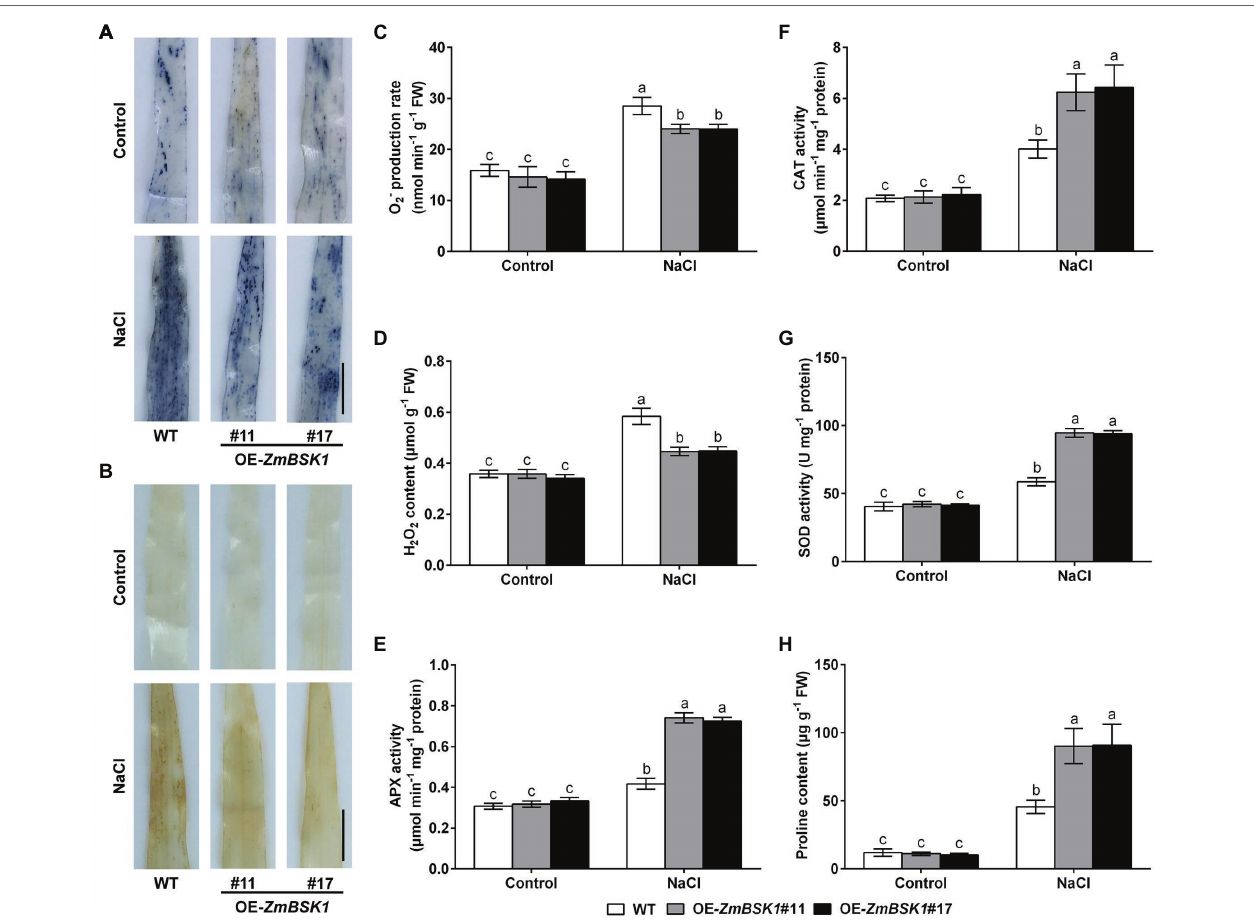
FIGURE 4 | Effect of ZmBSK1 on reactive oxygen species (ROS) levels, antioxidant defense enzymes activity and proline content under salt stress. Nitroblue tetrazolium (NBT) staining of O 2 − (A) and 3,3 ′ -diaminobenzidine (DAB) staining of H 2 O 2 (B) in leaves of OE- ZmBSK1 and WT maize plants under salt stress. Scale bar = 1 cm. Statistical analysis of O 2 − production rates (C) and H 2 O 2 content (D) in leaves of OE- ZmBSK1 and WT maize plants under salt stress. Ascorbate peroxidase (APX) activity (E) , catalase (CAT) activity (F) , superoxide dismutase (SOD) activity (G) , and proline content (H) in leaves of OE- ZmBSK1 and WT maize plants under salt stress. About 10-day-old maize seedlings in (A–H) were treated with 200 mM NaCl for 2 days, and then the above physiological indexes as indicated were measured. Error bars in (C–H) represent ±SD ( n = 3). Different letters indicate significant differences at p < 0.05 according to two-way ANOVA (Duncan’s multiple range